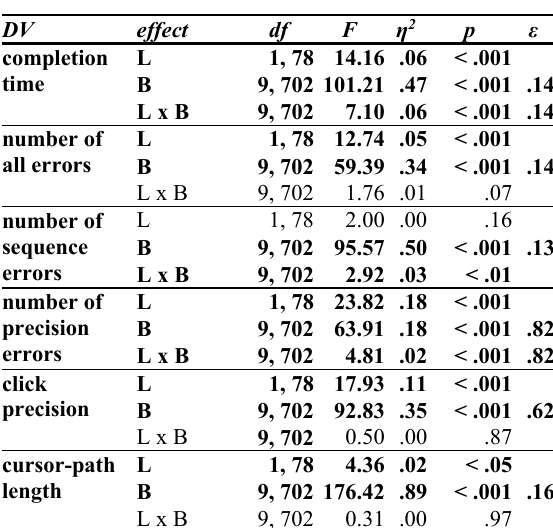
Table 7. ANOVA results of the learning phase of Experiment